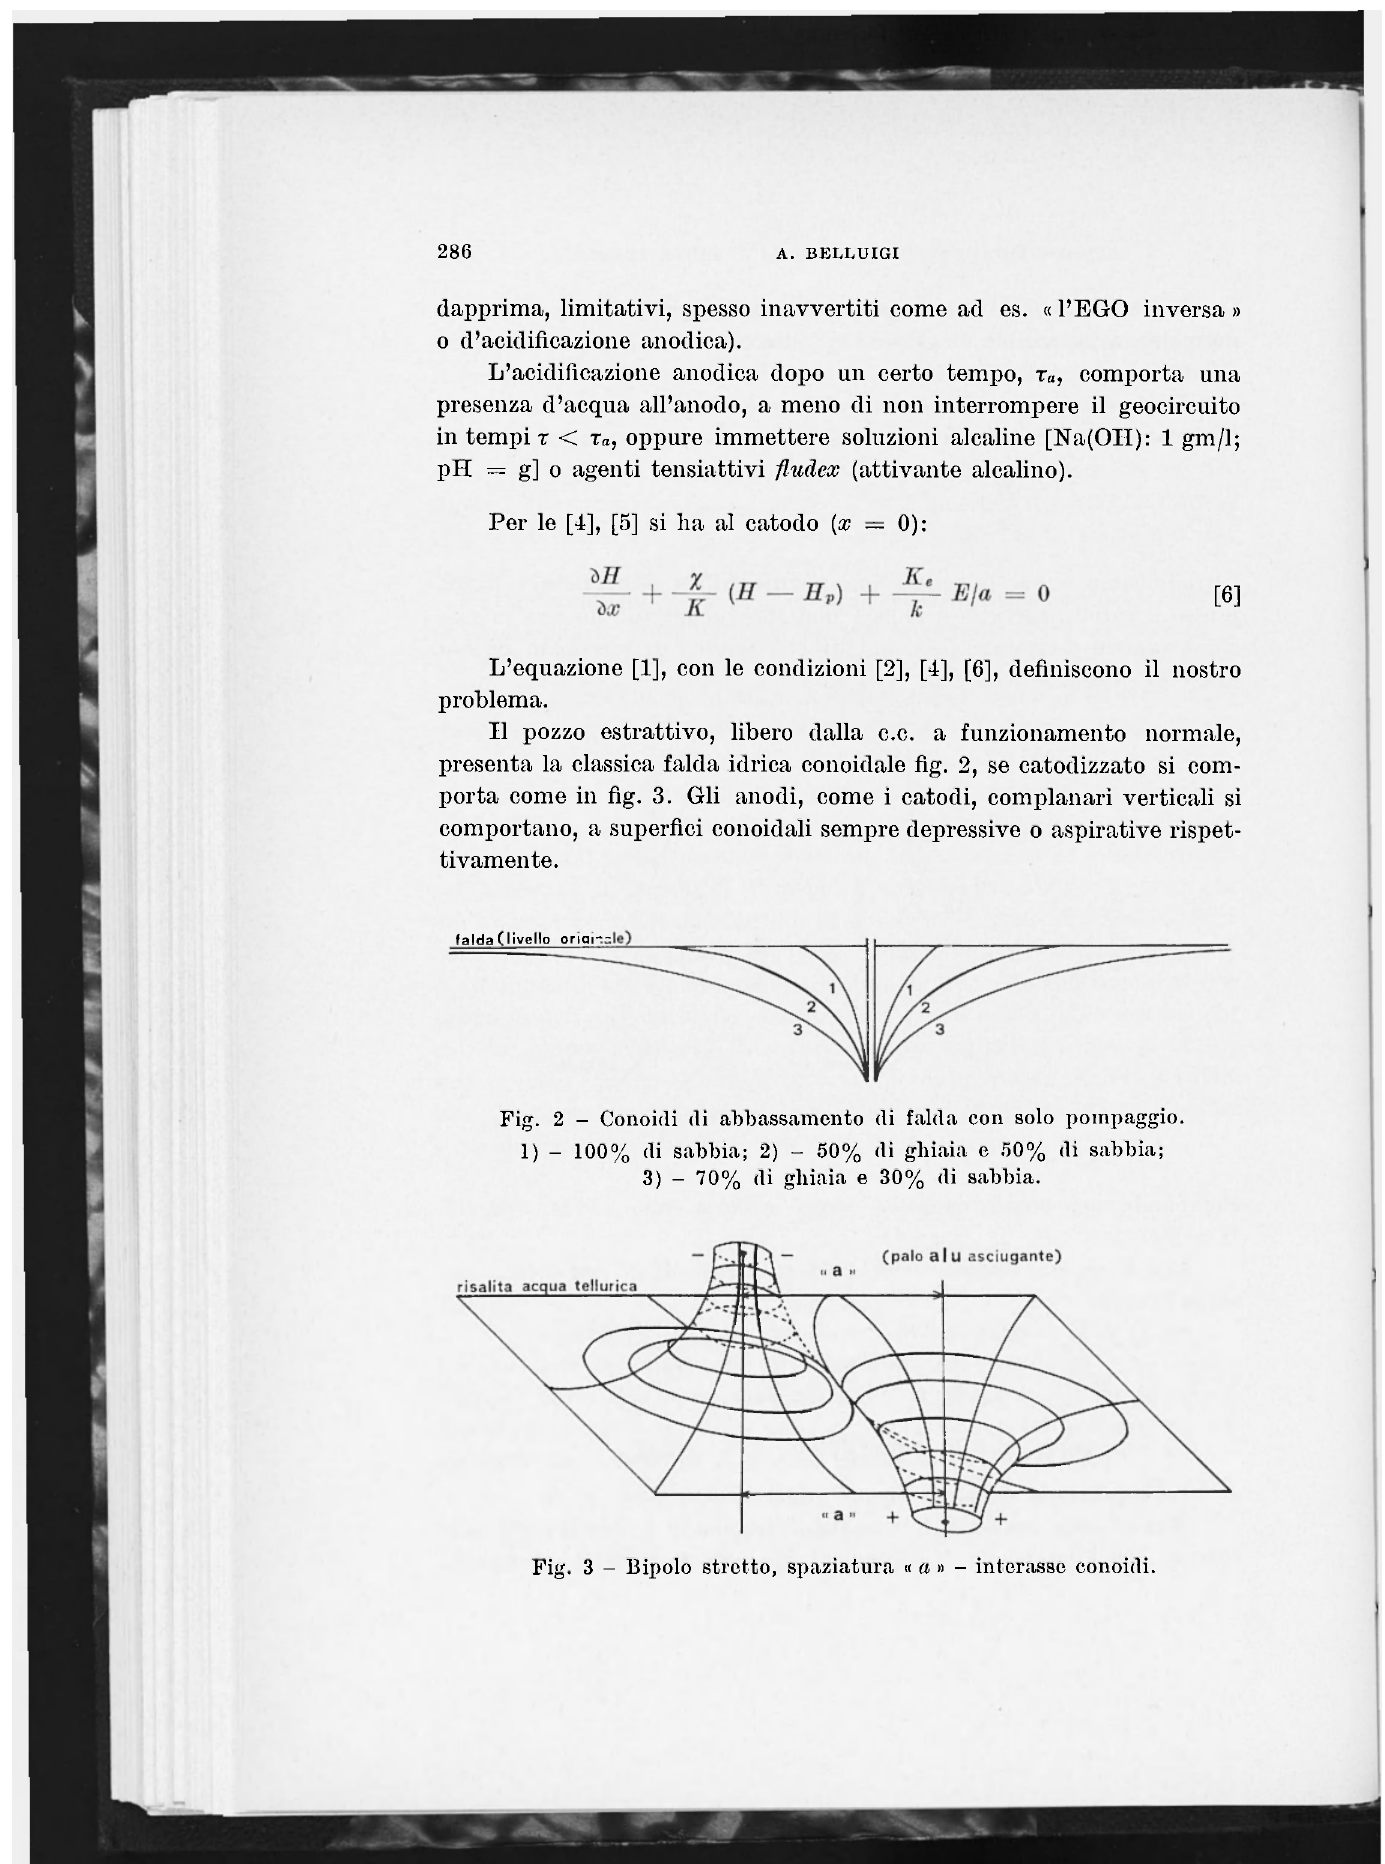
Fig. 3 - Bipolo stretto, spaziatura « a » - interasse